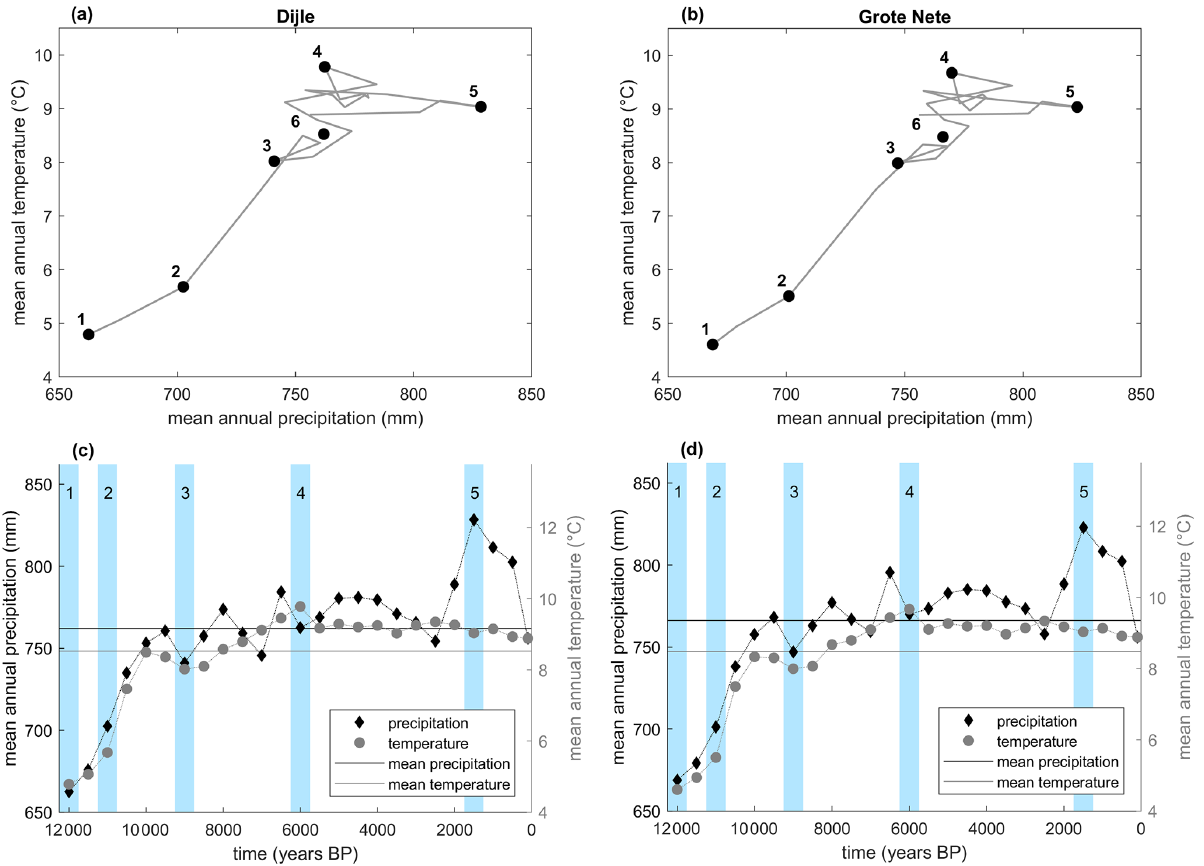
Figure 6. (a,b) Mean annual precipitation (mm) and mean annual temperature ( ◦ C) for each of the six climate scenarios for both the Dijle (a) and Grote Nete (b) river basins. The grey line indicates the climate evolution (12calkyr–100calBP) according to the pollen-based climate reconstruction (Mauri et al., 2015). (c,d) Temporal evolution of the mean annual precipitation (mm) and mean annual temperature ( ◦ C) over the studied time period (12kyr–100BP) for the Dijle (c) and Grote Nete (d) river basins, according to the pollen-based climate reconstruction. The blue areas indicate the time periods corresponding to the conditions of climate scenarios 1–5. The horizontal lines indicate the mean values over the studied period, which correspond to climate scenario 6. Table 1. Vegetation fractions (%) for each of the five land cover scenarios. Land cover scenario Forest [%] Grassland/short vegetation